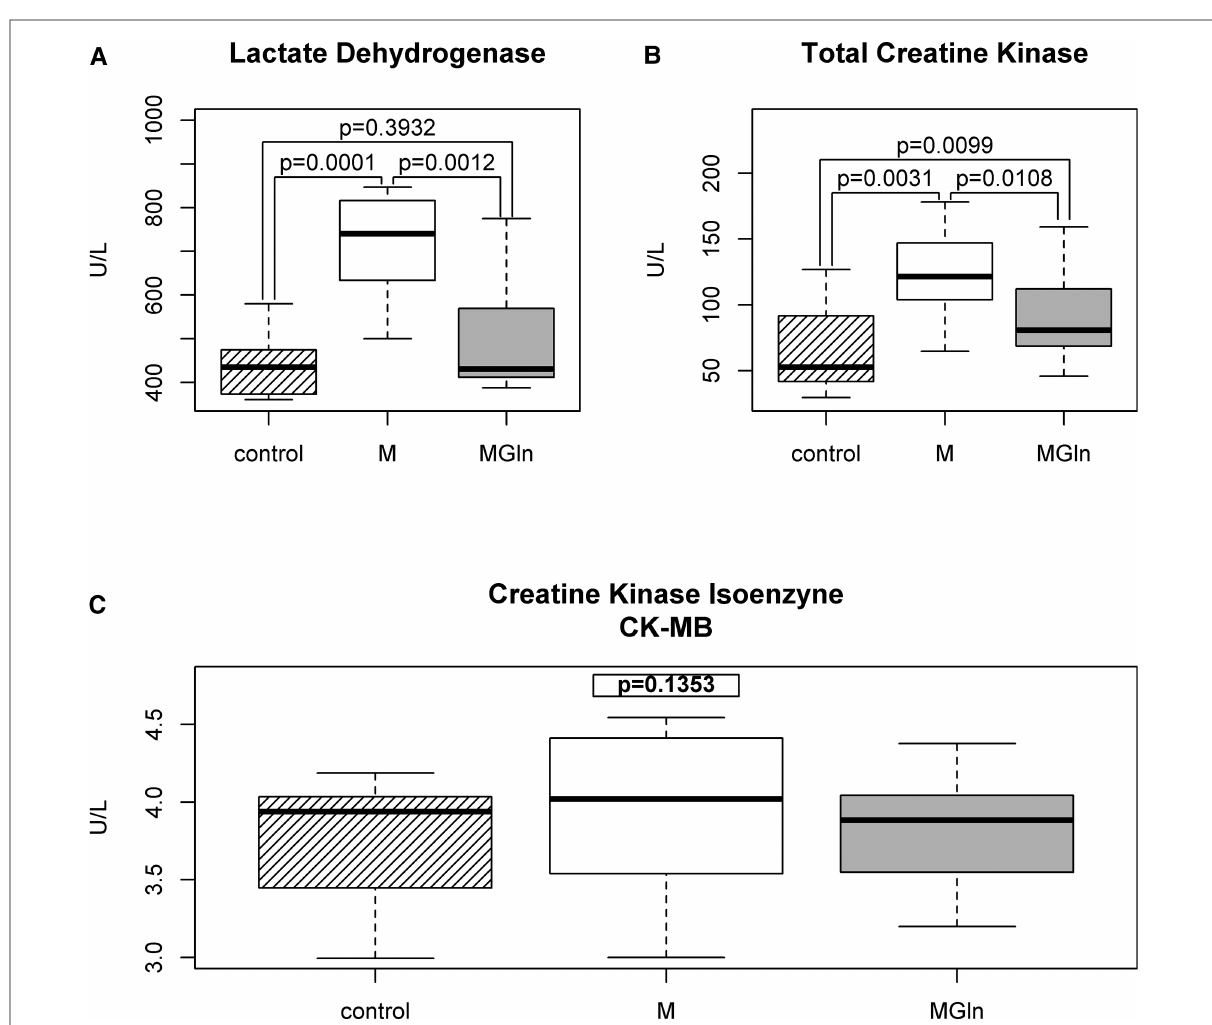
FIGURE 5 Muscle damage in athletes supplemented with maltodextrin (M) or maltodextrin plus hydrolyzed protein enriched with glutamine (MGln). Plasma activities of lactate dehydrogenase ( A ), total creatine kinase ( B ), and myocardial creatine kinase isoenzyme (MB-CK) (U/L) ( C ) in the periods before the tests and after maltodextrin (M) or maltodextrin and hydrolyzed whey protein enriched with glutamine (MGln) supplementation immediately after the end of the endurance test. For both tests, a signi fi cance level of 0.05 was